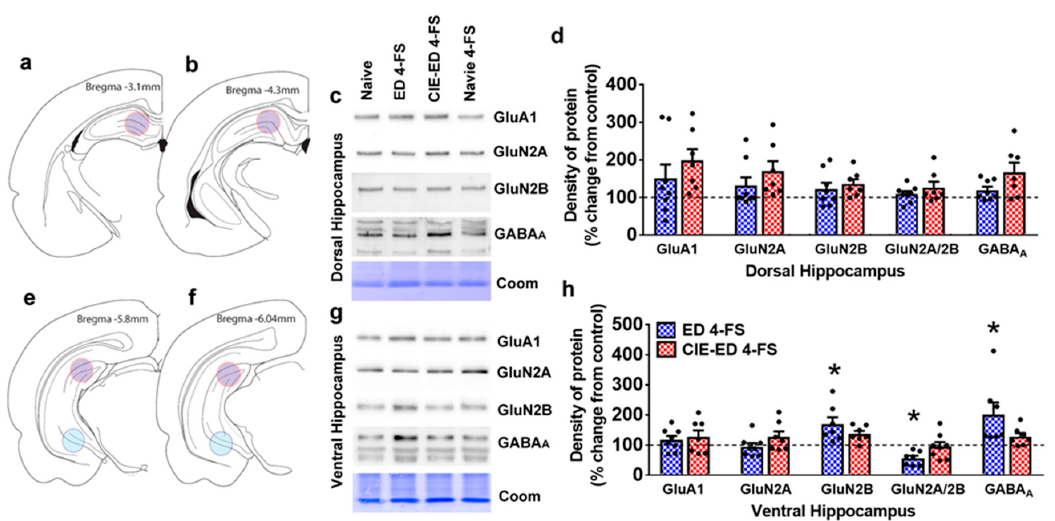
Figure 6. ( a , b , e , f ) Schematic of tissue punches from the dorsal hippocampus ( a , b ) and ventral hippocampus ( e , f ). ( c , g ) sample western blots from dorsal ( c ) and ventral ( g ) hippocampus tissue punches. ( d , h ) Densitometric analysis of tissue for levels of GluA1, GluN2A, GluN2B, ratio of GluN2A/2B and GABA A from the dorsal ( d ) and ventral ( h ) hippocampus tissue homogenate. n = 8 4 ‐ FS ED rats, n = 7 4 ‐ FS CIE ‐ ED rats. Values are mean ± S.E.M. expressed as % control, where control is Int. J. Mol. Sci. 2020 , 21 , x FOR PEER REVIEW represented by the dotted line in each graph. * p < 0.05, compared to controls. In the ventral hippocampus, GluN2B and GABA A expression were increased (one ‐ way ANOVA, GluN2B: F(2,18) = 1.5; p = 0.03; GABA A : F(2,17) = 1.6; p = 0.04). Post hoc analysis indicated higher